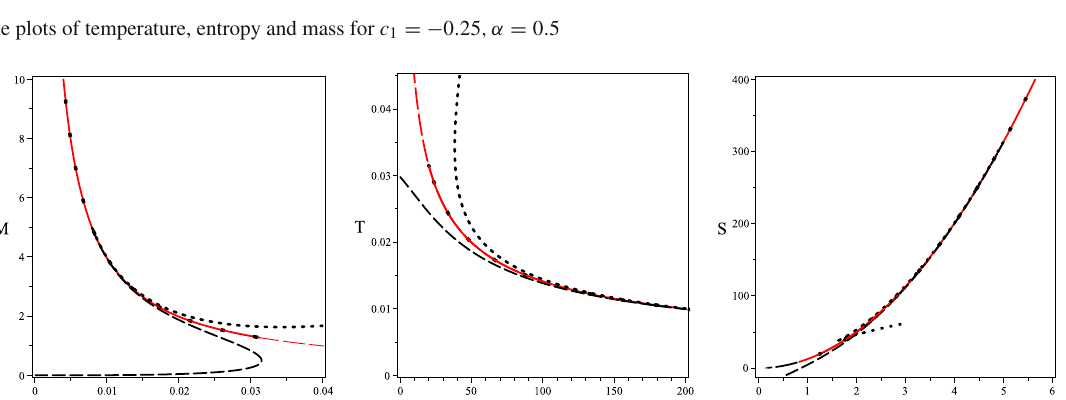
Fig. 5 The plots of temperature, entropy and mass for c 1 = − 0 . 25 ,α = 0 . 5